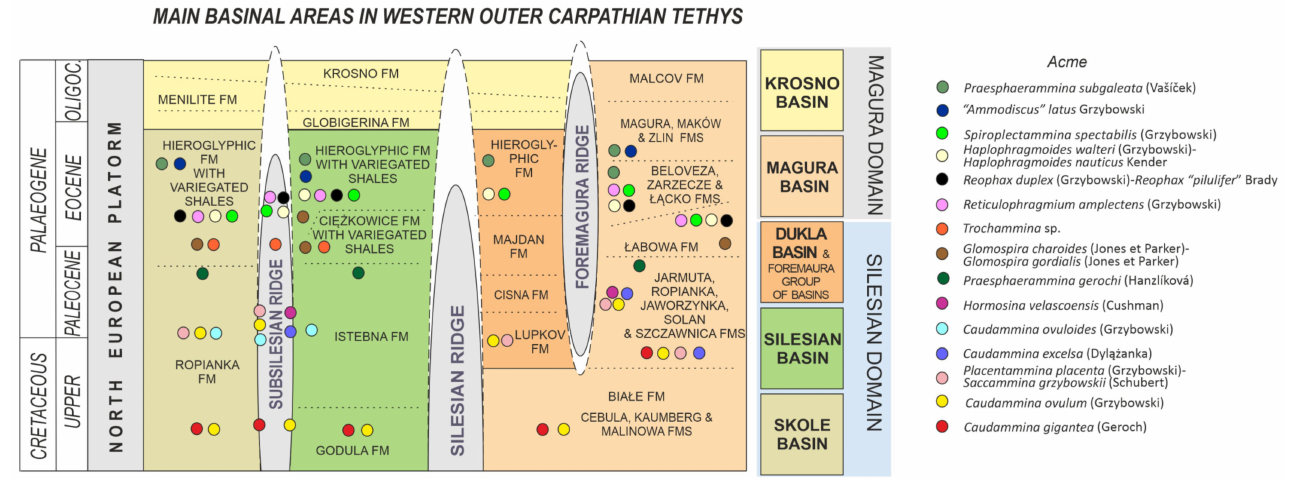
Figure 5. Main basinal lithostratigraphic units with acmes in the Outer Western Carpathians (on the basis of